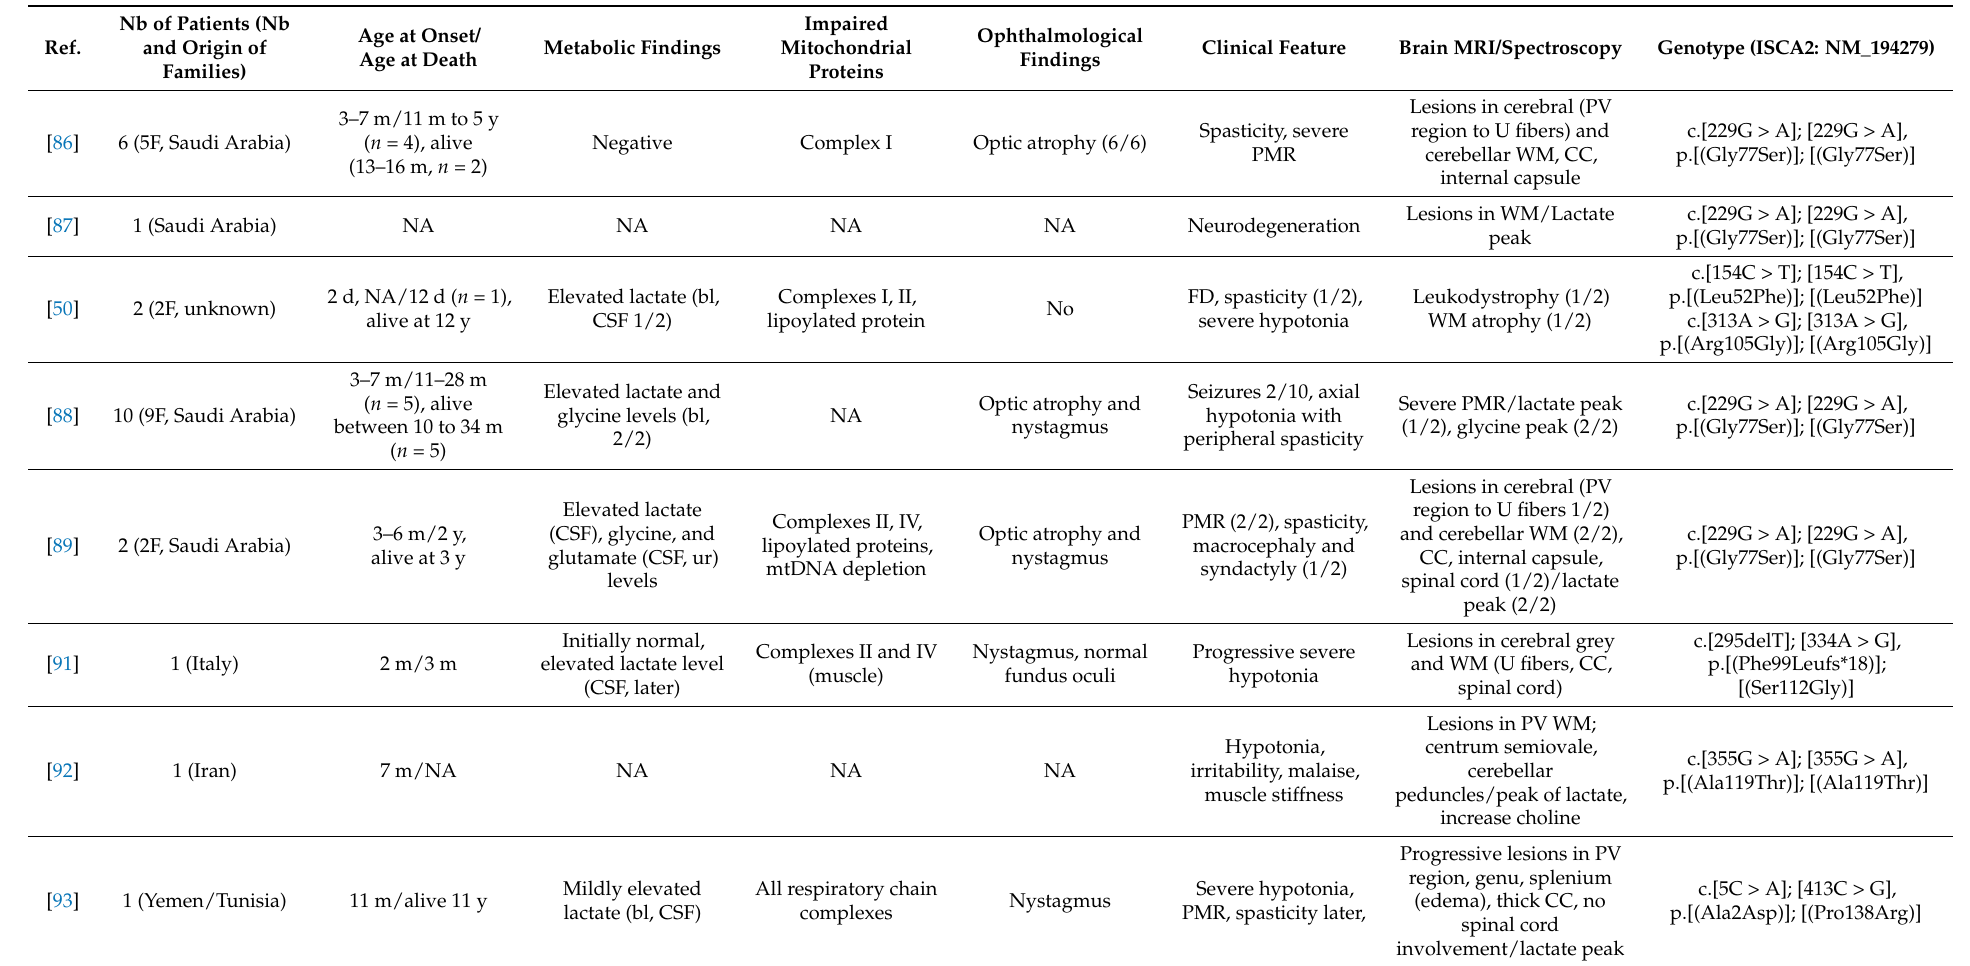
Table 4. Reported cases with MMDS type